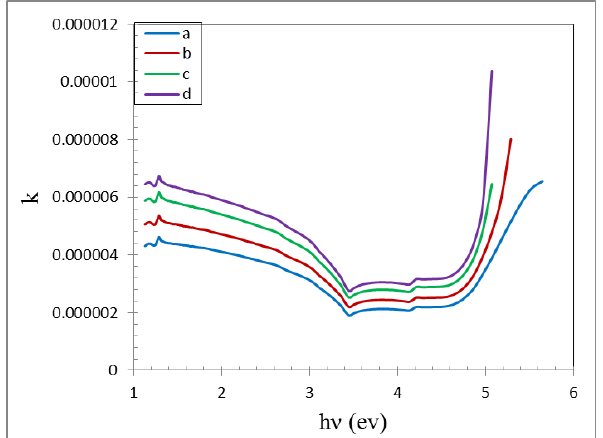
Fig.5: Extinction coefficient as a function of photon energy of glass for different doping concentrations of graphene oxide thin films ((a) 2%, (b) 4%, (c) 6%, (d) 8% wt.